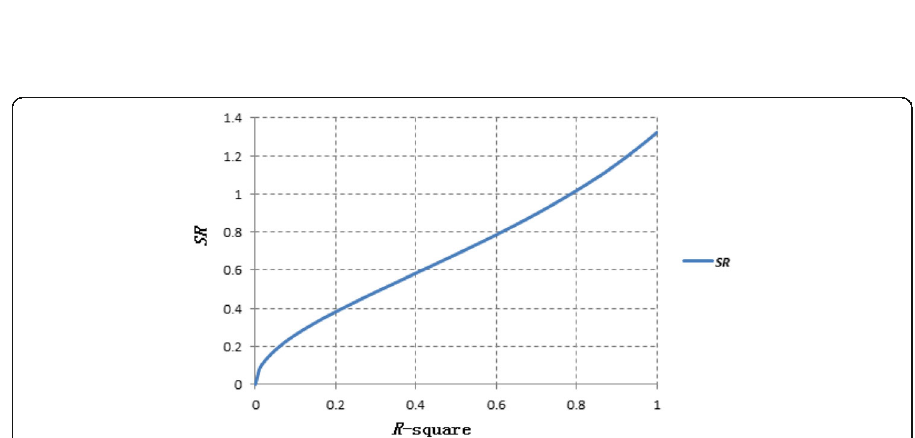
Fig. 1 The relationship between the Sharpe ratio and R-squared. The horizontal axis shows the R-squared , and the vertical axis shows the Sharpe